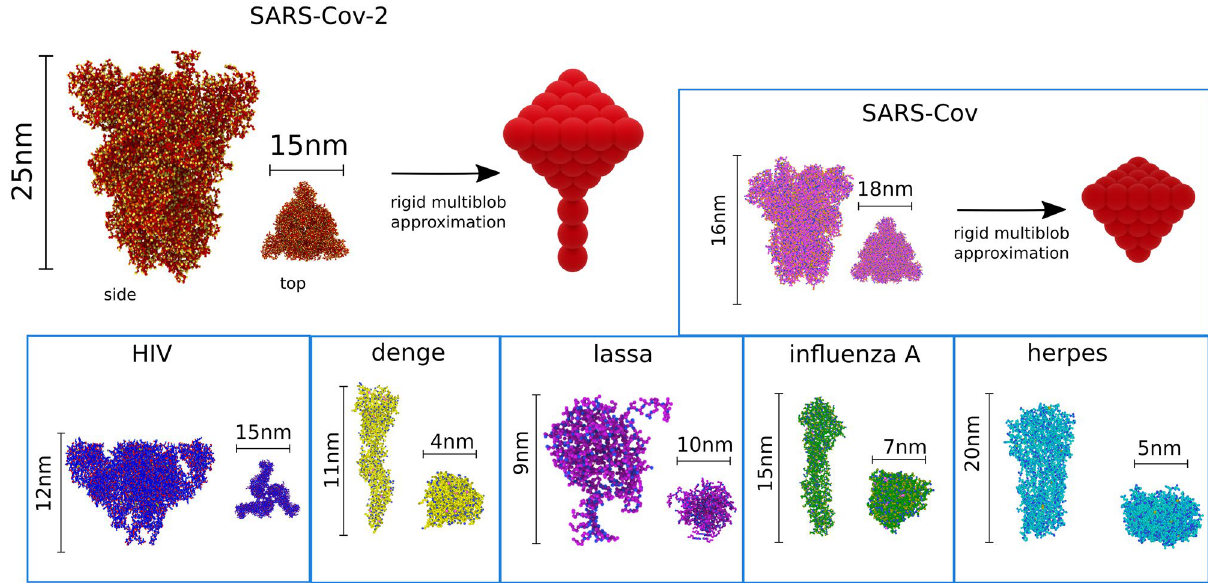
Figure 5. Discretization adopted to model the surface-protein morphology of different virions. The characteristic sizes are shown for: HIV 39 , dengue 40 , SARS-Cov-2 41 , SARS-Cov 42 ,lassa 43 , influenza 44 , and herpes 45